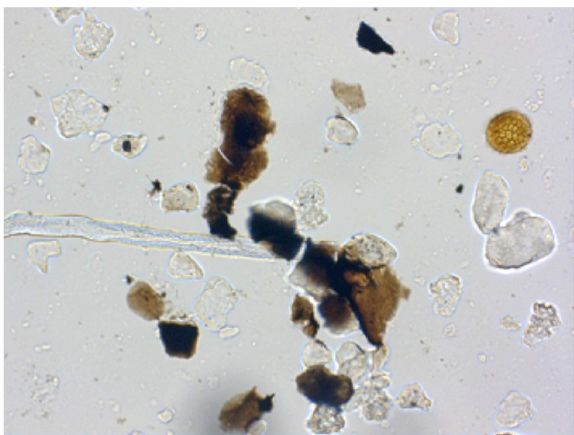
Figure 11. Photograph showing organic residue with degraded cu- ticle, charcoal, and wood fragments. Identifiable sporomorphs are modern Lycopodium spores added to calibrate abundances during palynological